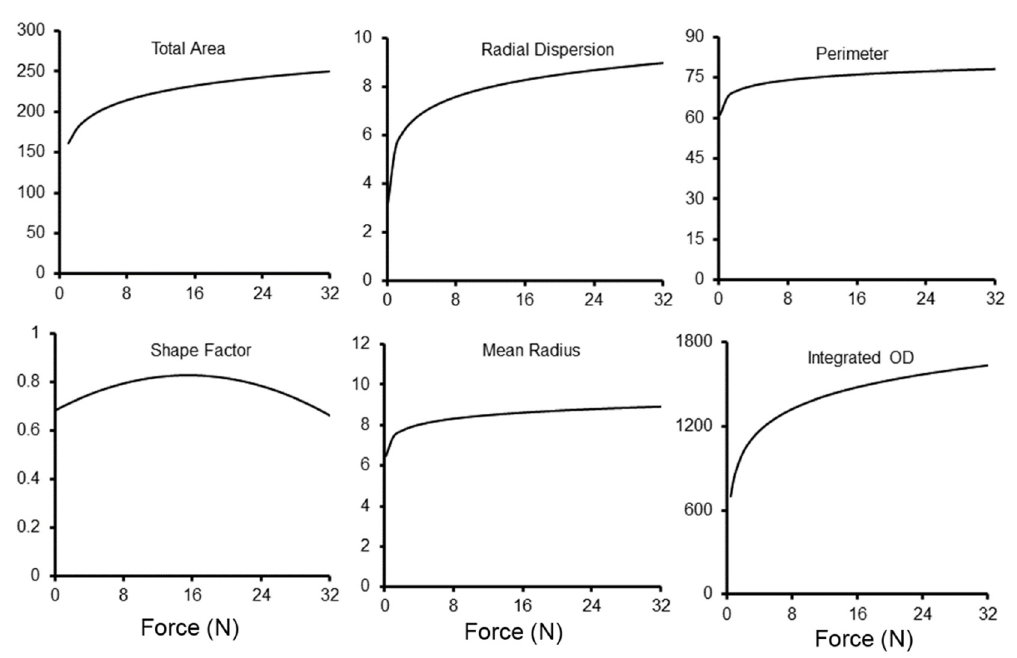
Figure 8. Morphometric analysis of methylene blue loading with variable compression force. The morphometry measures reflecting the area or radial dispersion of the tracer increased toward an apparent plateau of 10 N. The morphometric measures continued to increase marginally with added force. The curves reflect the aggregate best fit curve based on replicate measures of contact time and